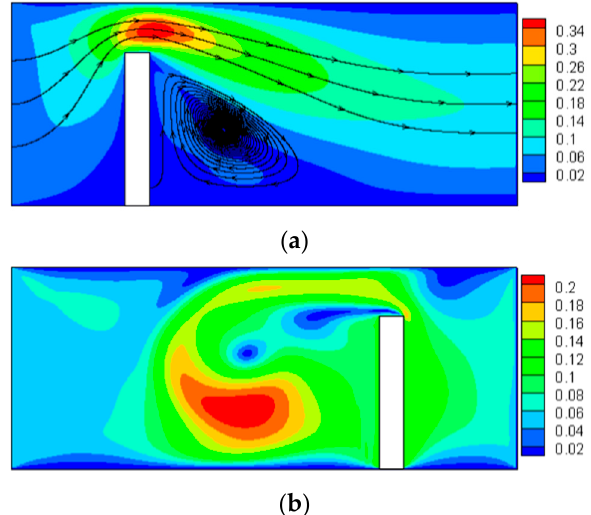
Figure 6. The distribution of velocity with a pin fin. ( a ) Static pin fin, ( b ) Moving pin fin.